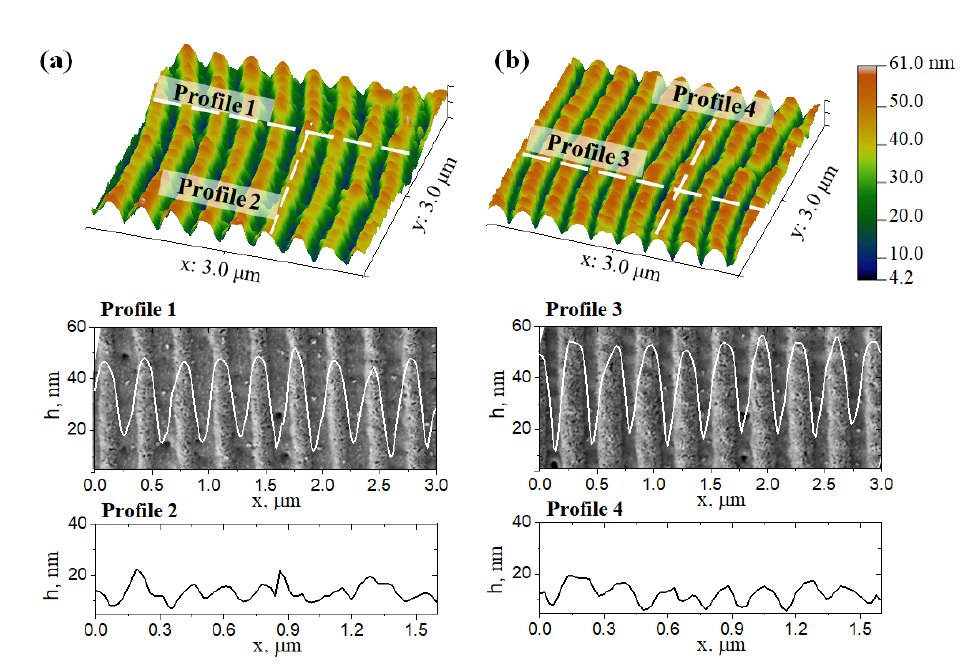
Figure 2. Surface topology of the periodic gratings obtained in various laser processing modes. Three-dimensional relief maps obtained using AFM and the corresponding surface relief profiles: ( a ) N = 540, F = 21 mJ/cm 2 ; ( b ) N = 540, F = 23 mJ/cm 2